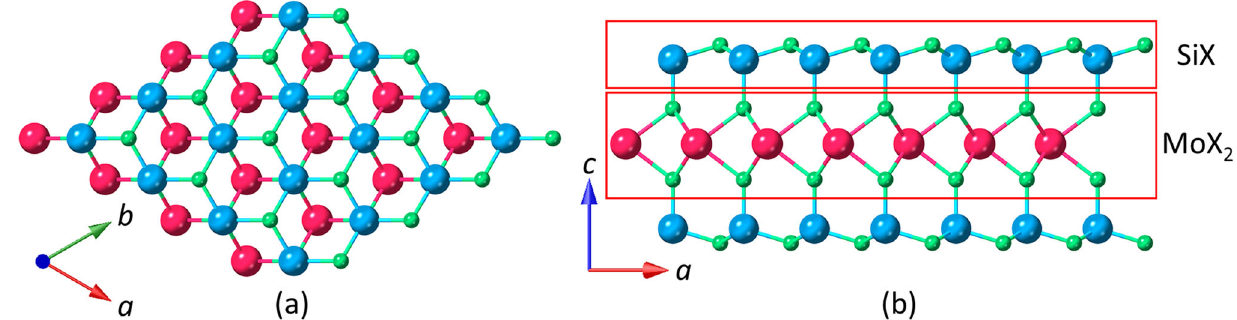
Fig. 1 Atomic structure. Top a and side b views. In b the MoX 2 and SiX layers are marked. The violet, blue, and green spheres are Mo, Si, and X atoms, respectively.